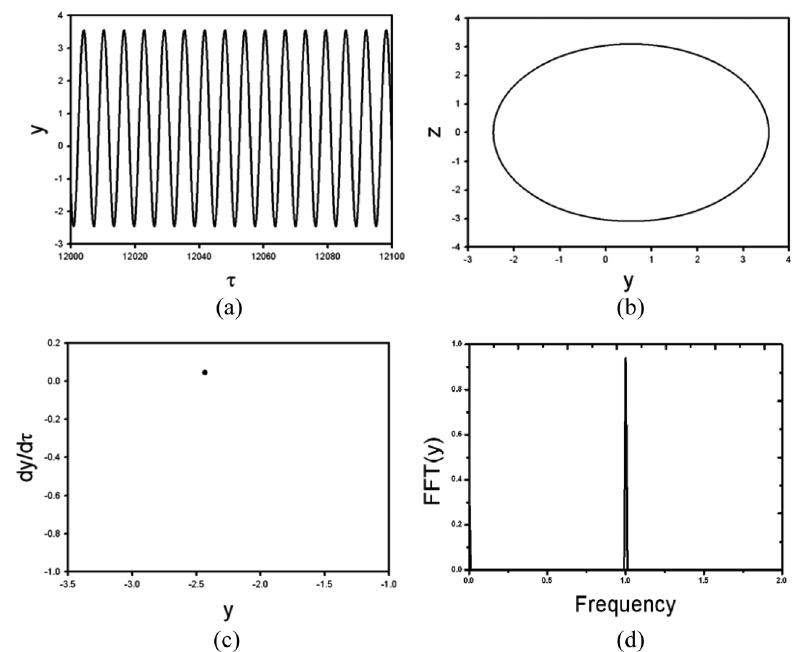
Fig. 10. Dynamic characteristic of the y-displacement of the mid-span point with ω = 350 rad/s. (a) Time history; (b) Orbital trajectory; (c) Poincar´e section; (d)